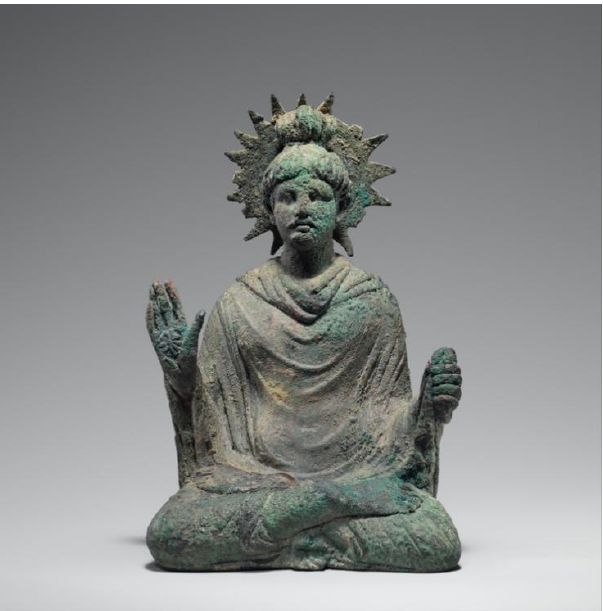
Figure 2. The gilded bronze seated Buddha of Shakyamuni from Gandhara, 1st to mid-2nd century. Materials: gilt bronze. Dimensions: H. 16.8cm × W. 11.4 cm × D. 10.2 cm. Displayed in the Metropolitan Museum of Art, New York, United States of America. Photo source: the official website of the Metropolitan Museum of Art (Behrendt 2007, p. 49).